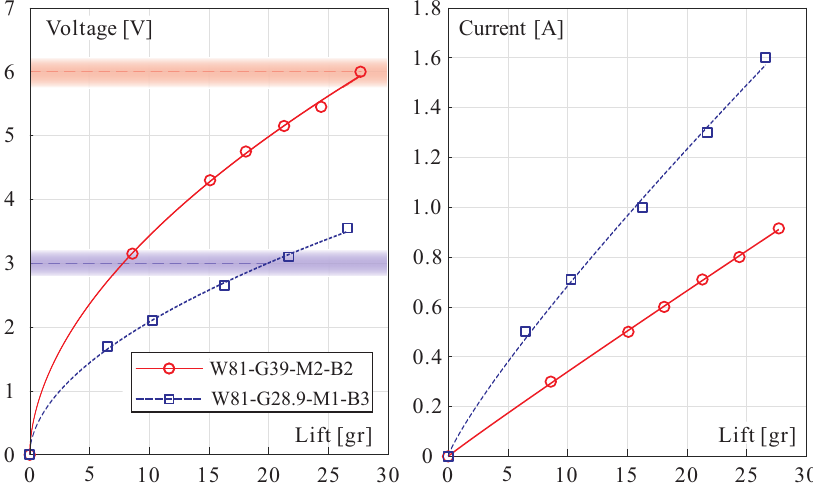
Figure 13. Voltage vs. Lift ( left ) and Current vs. Lift ( right ) for two flight configurations (with a single battery B3 and two batteries B2 in series). The shaded areas correspond to the voltage